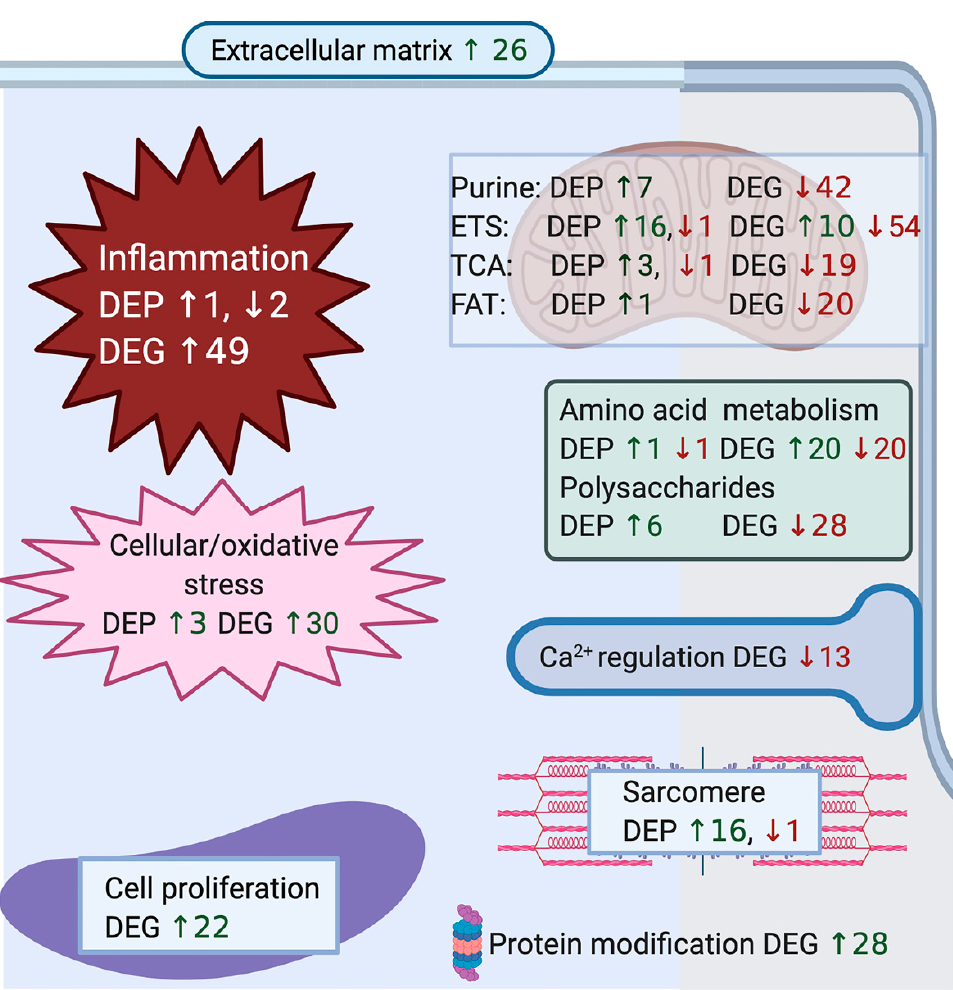
Figure 3. Illustration of convergent pathways for differentially expressed genes and proteins. The number and cellular location of up and downregulated differentially expressed genes (DEG) catego- rized by convergent pathways for GO terms in biological processes (see Table S4 for specific GO terms and genes) were combined with the number of up and down regulated significantly differentially expressed proteins (DEP) (see Tables 3 and 4 for specific proteins) in RER-susceptible compared to control horses. The number of genes corresponds to the number of genes in the GO term with the largest gene set for the convergent pathway (Table S4). DEP and DEG for processes of purine nucleotide metabolism, the electron transfer system (ETS), tricarboxylic acid cycle (TCA) and fat metabolism are depicted within the mitochondrion. Between episodes of rhabdomyolysis, RER- susceptible horses showed upregulation of cellular inflammation, cellular/oxidative stress response, cell regeneration, protein modification and sarcomere proteins. Metabolic pathways were high- lighted in the GO analysis in RER-susceptible horses with a notable increase in expression of pro- teins and decrease in expression of genes related to oxidative metabolism, amino acid, and polysac- charide metabolism. DEG in sarcoplasmic reticulum calcium (CA) transport included downregula- tion of the dihydropyridine receptor ( CACNA2D1 ) and fast twitch calsequestrin ( CASQ1 ) and up- regulation of slow twitch CASQ2. There was no DEP related to calcium regulation in RER-suscepti- ble versus control horses. Table 2. Summary of categories for GO terms that were enriched for upregulated and downregu- lated genes (DEG) in biological processes and pathways in the Reactome (RH) for combined DEG and DEP. The number of GO terms in each category and the range in number of genes within the GO terms in each category are shown. The specific GO terms can be found in Table S4 and Reactome terms in Table S7.